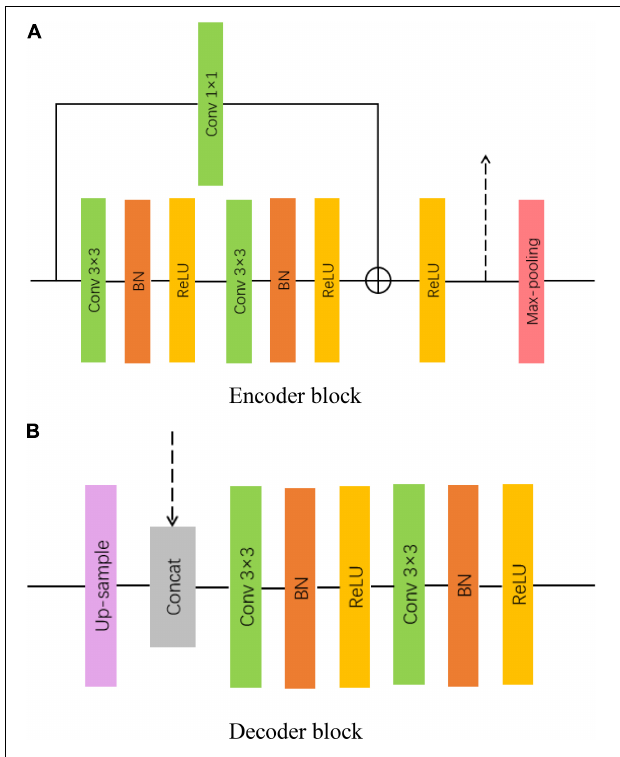
FIGURE 3 | Encoder and decoder block in MAFF-ResUNet (A) encoder block (B) decoder block.